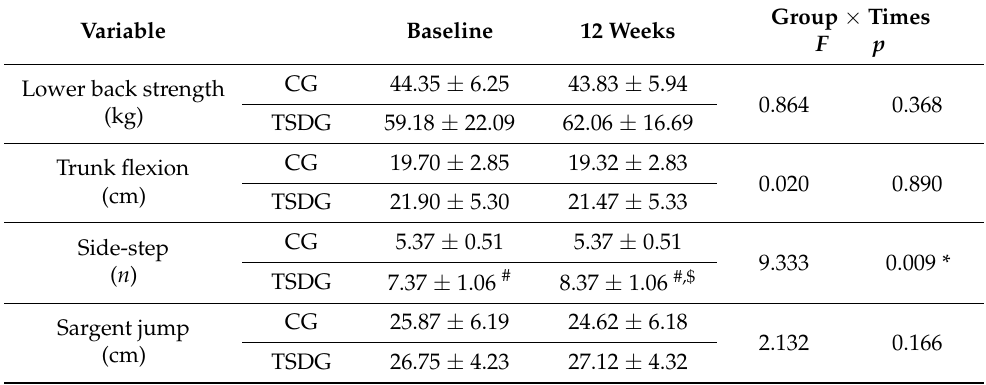
Table 5. Changes in physical fitness after the 12-week Taekwondo training intervention.